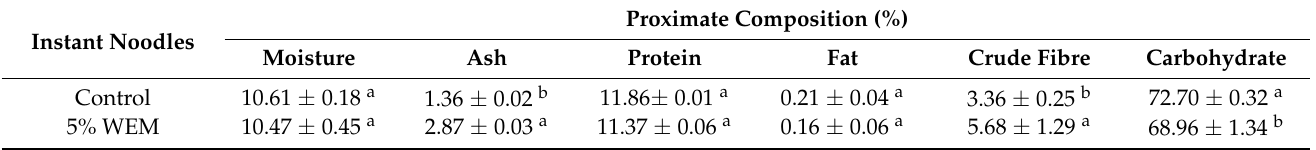
Table 1. The proximate composition of noodles incorporated with WEM and without WEM (control).